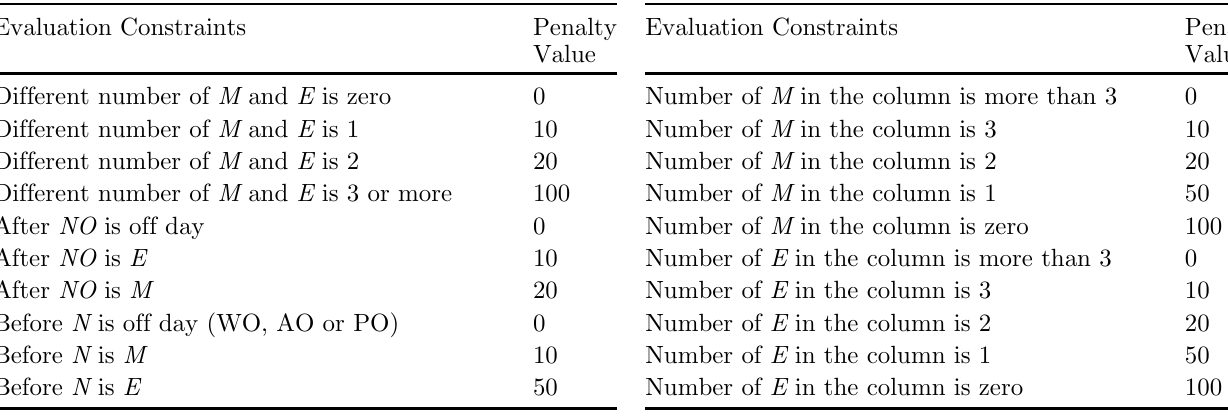
Table 1. Evaluation constraints for every row. Table 2. Evaluation constraints for every